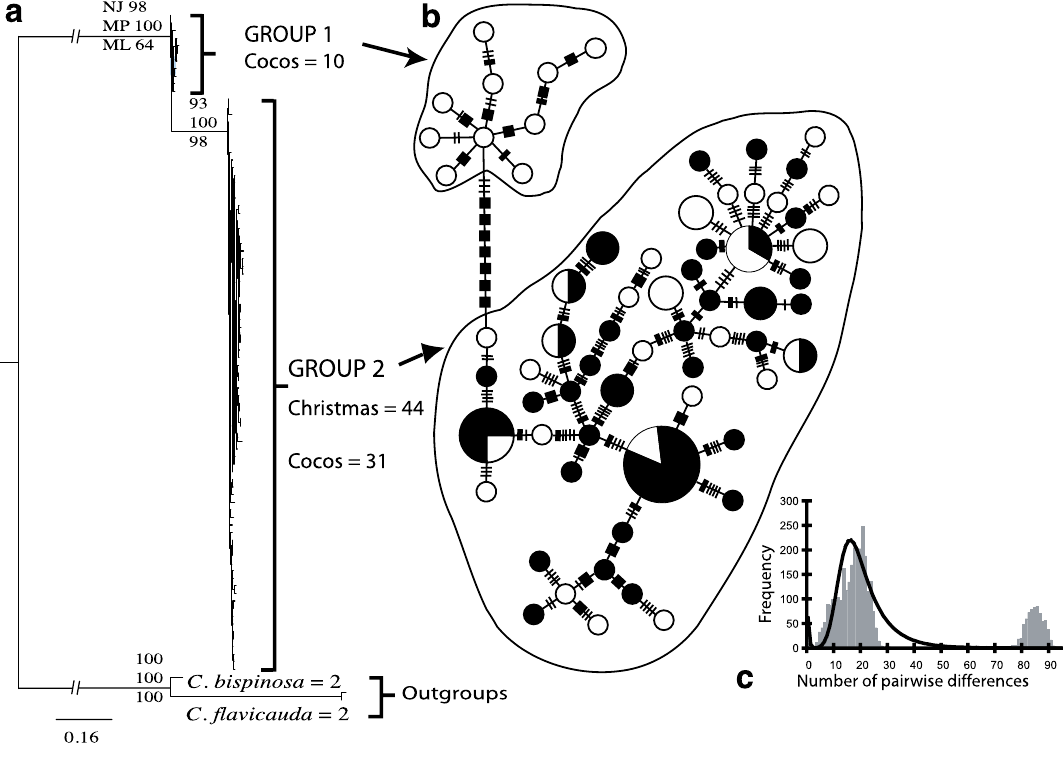
Figure 1. (a) Outgroup rooted phylogram based on 436 bp control region mtDNA sequences from 85 Centropyge joculator individuals (44 from Christmas Island and 41 from the Cocos Islands). The NJ, MP and ML majority rule bootstrap consensus support values are displayed at each node. (b) Minimum spanning tree of C. joculator haplotypes. Black filled circles are Christmas Island individuals and unfilled circles are individuals from the Cocos Islands. The size of the circle indicates the relative frequency of each haplotype (smallest circle = 1 individual, largest circle = 6 individuals). Bars indicate the number of substitutions between haplotypes, with thin bars = 1 substitution, medium bars = 5 substitutions, and thick bars = 10 substitutions. (c) Mismatch distribution of pairwise sequence differences for C. joculator and the expected distribution of pairwise sequence differences under an expansion